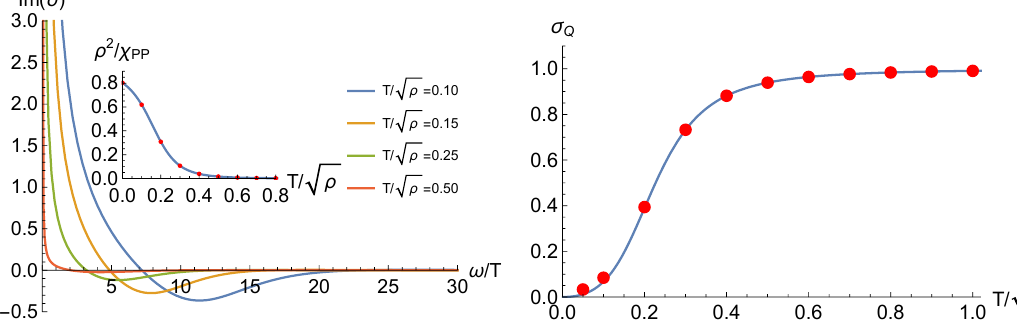
Figure 7 . Left : the imaginary parts of AC conductivity for different temperatures. The inset plot shows the Drude weight ρ 2 /χ . Blue line is the analytical result obtained from (4.1) and red PP dots are the numerical results from (4.8). Right : the incoherent conductivity σ as the function of Q temperature. Blue line is the analytical result obtained from (4.2) and red dots are the numerical results from (4.8). We have fixed K = − 1 / 8 and λ = 0 .